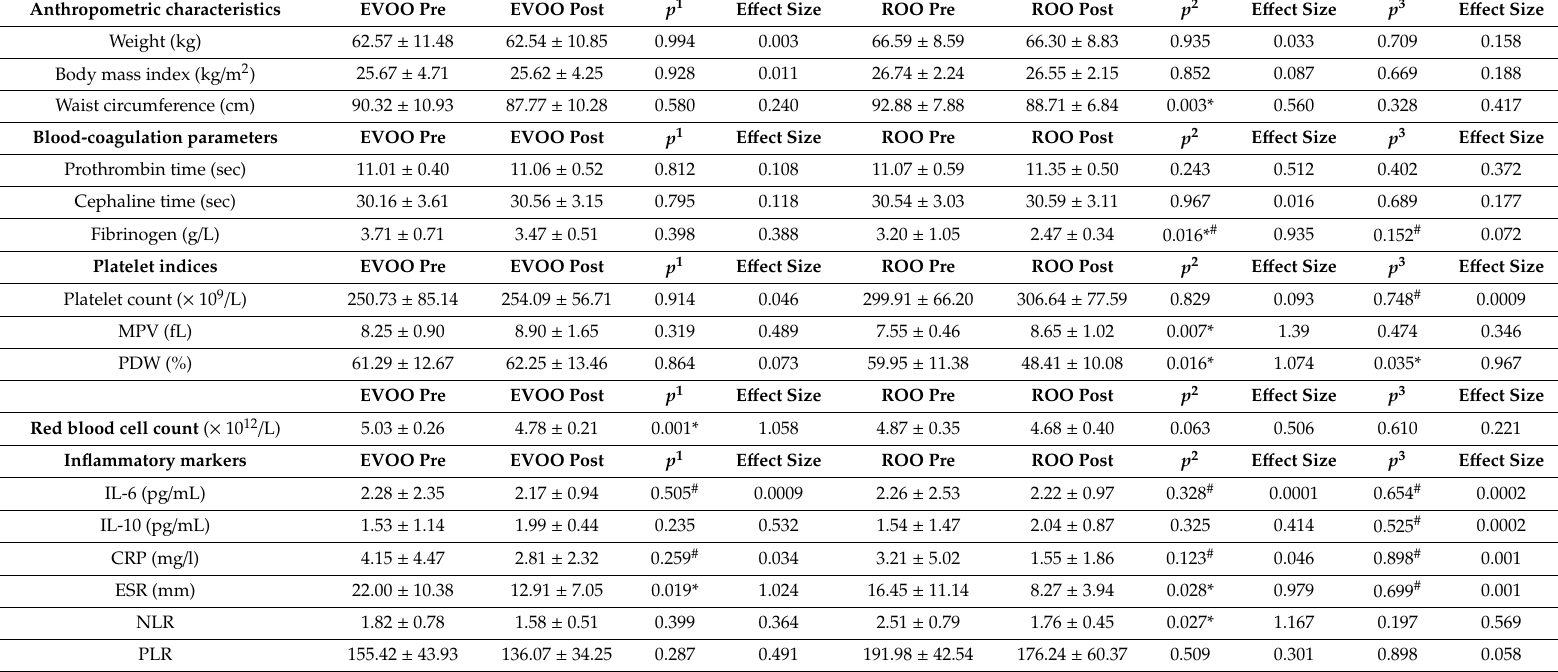
Table 2. Anthropometric characteristics and cardiovascular risk markers before and after olive oil consumption in patients with fibromyalgia. Anthropometric